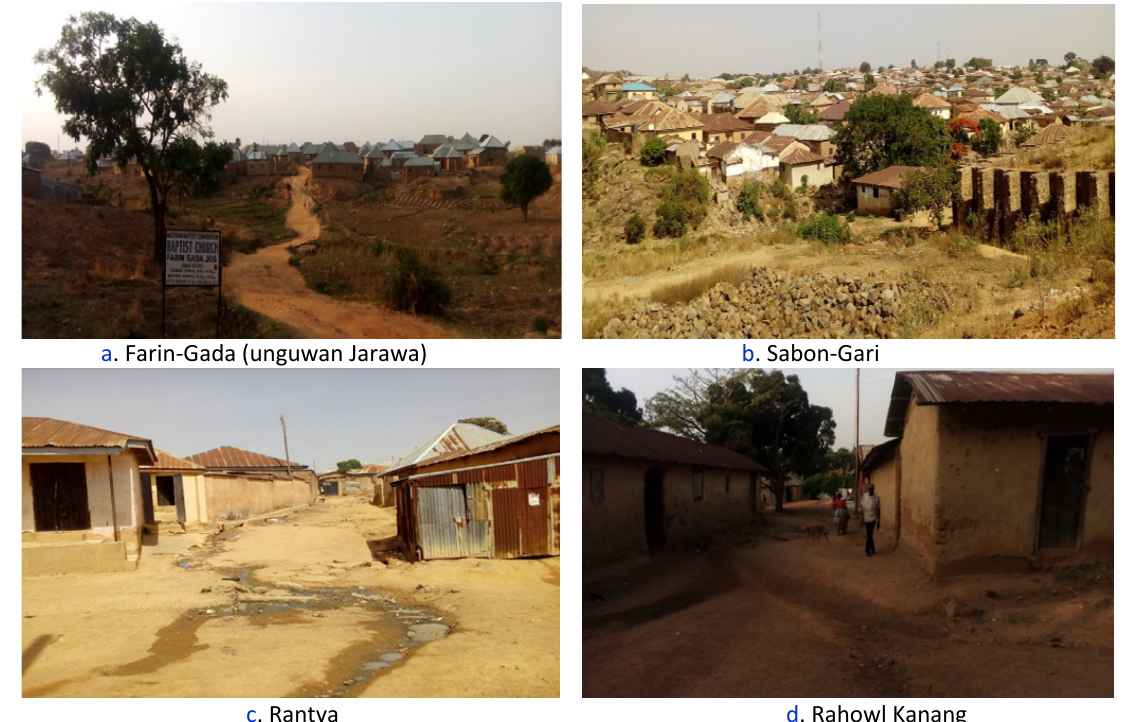
Fig. 8: Sporadic nature of growth in peri-urban areas of Jos